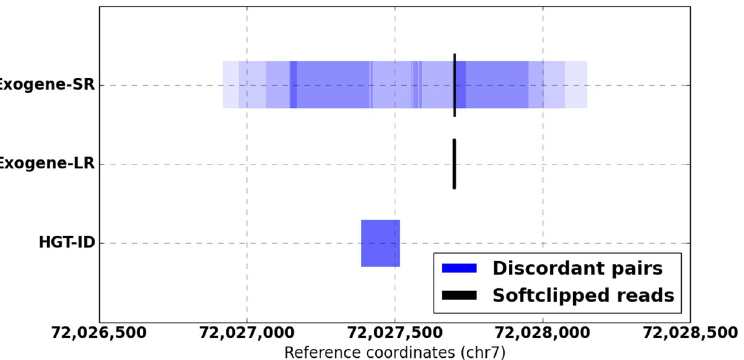
Fig 2. Comparison of evidence for HBV integration at chr7:72,027,703 from Exogene and HGT-ID. Shaded regions indicate breakpoint ranges as inferred from read fragment lengths and orientations, darker shades indicate greater